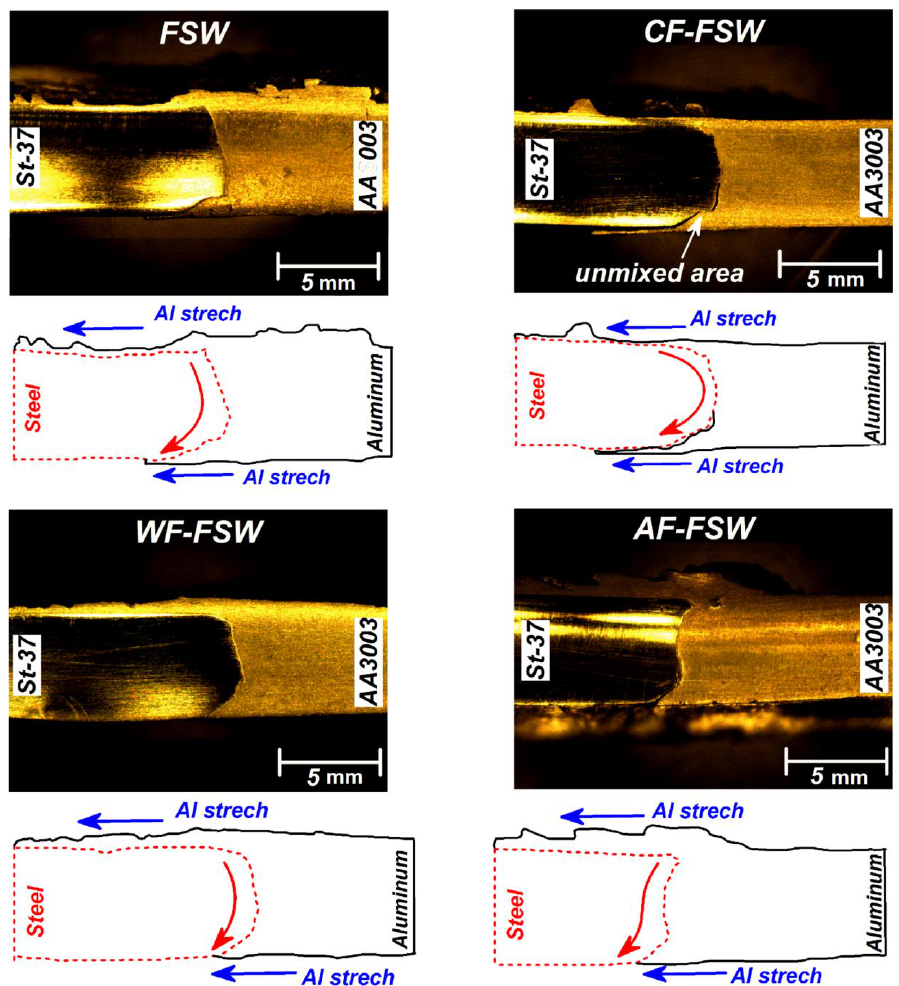
Figure 3 Figure 3. Weld cross-section macrograph of FSW, CO 2 -forced cooling FSW (CF-FSW), water-forced cooling FSW (WF-FSW), and air-forced cooling FSW (AF-FSW) samples and schematic view of internal material